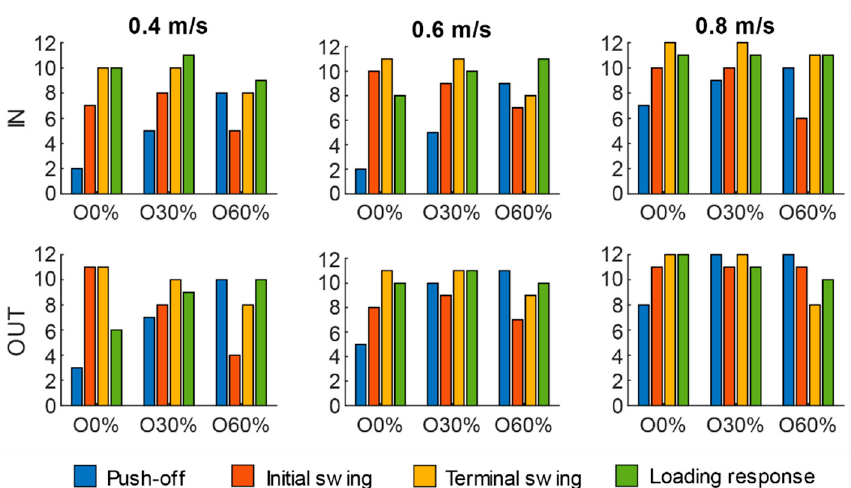
Figure 8. The summative count of the separate muscle synergies (push-off, initial swing, terminal swing, and loading response synergies) similar to the corresponding unperturbed synergy over all subjects. IN, OUT; inward-, outward-directed perturbation; O0%, O30%, O60%: perturbation onset of 0%, 30%, 60% of the stance phase of the gait cycle.